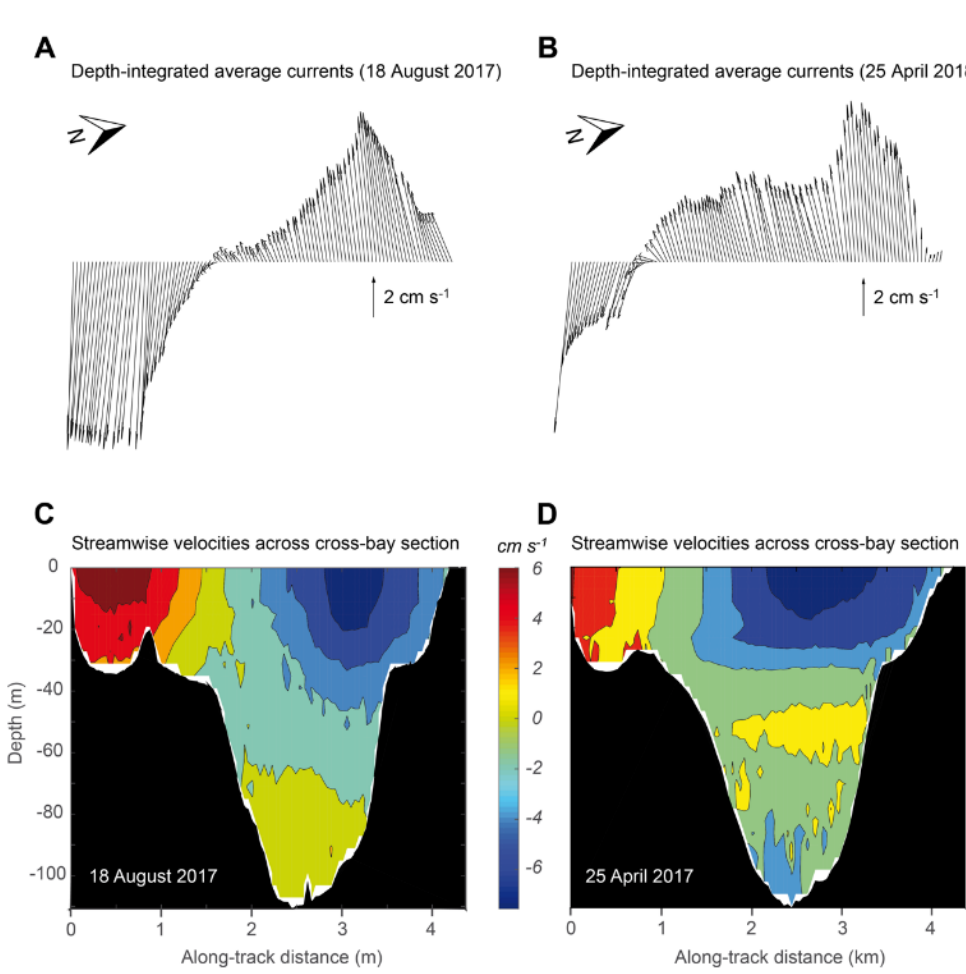
Figure 11. Current intensity and direction along the section across the bay for ( A ) August 2017 and ( B ) April 2018. The sections were repeated over part of the tidal cycle and covered periods of flow and ebb. The side views of the sections for ( C ) August 2017 and ( D ) April 2018 show the magnitude of the currents normal to the section, entering and leaving the bay, averaged over the different crossings. The top views show the depth-integrated currents along the section averaged over the various passages in both seasons. Water 2020 , 12 , 324